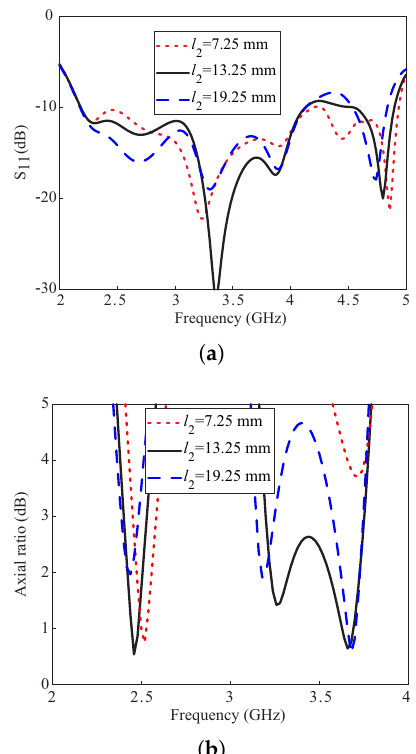
Figure 6. Simulated effects of varying the length l 2 of the DR: ( a ) Reflection coefficients; ( b ) Axial ratios.